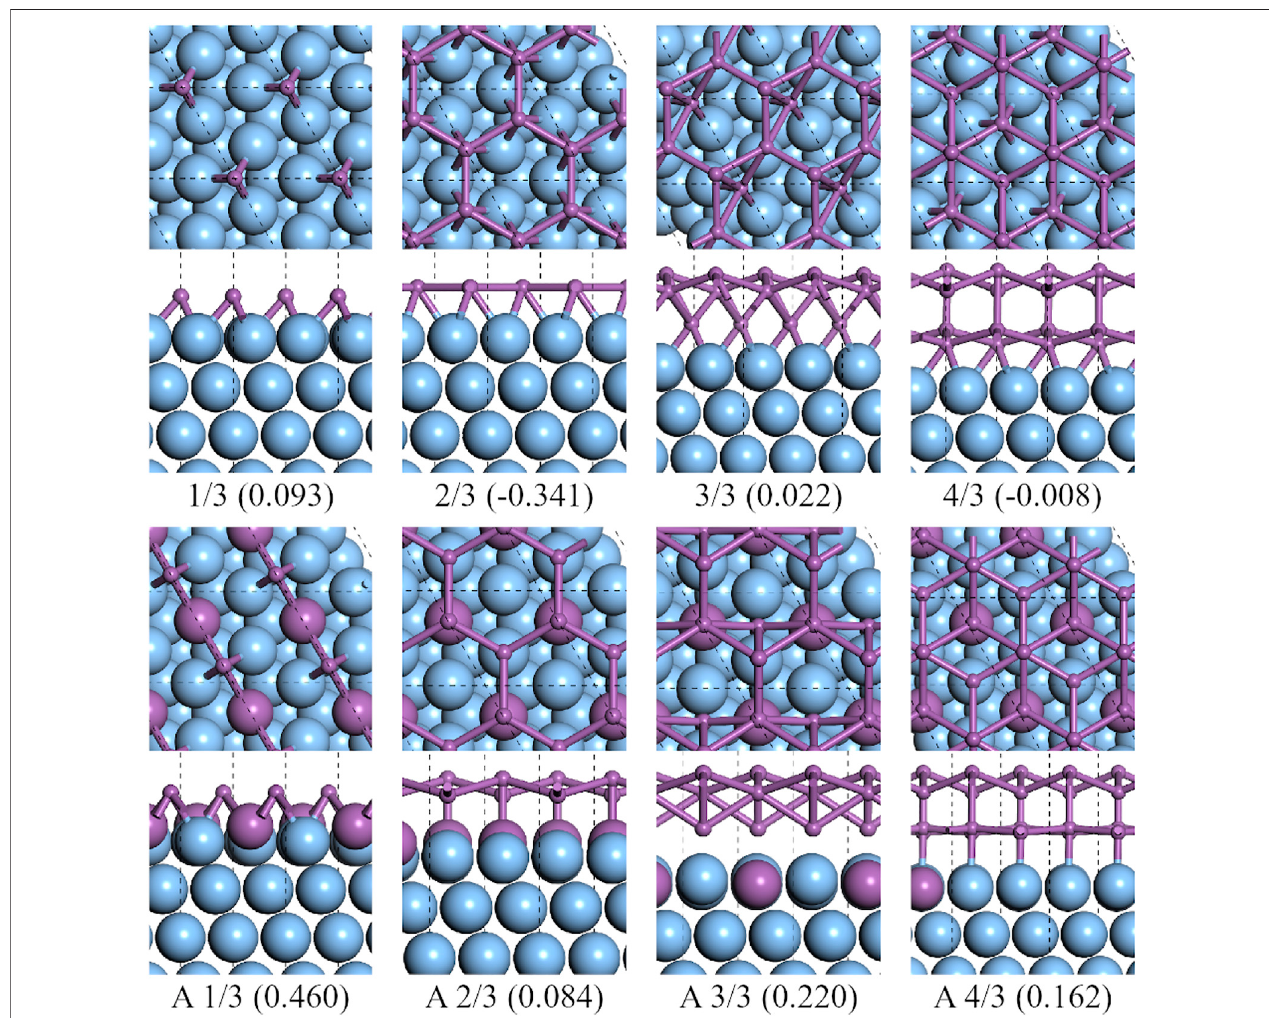
(cid:1)(cid:1) √ (cid:1)(cid:1) √ 3 × 3 Ag (111) and Ag 2 Sb/Ag (111)